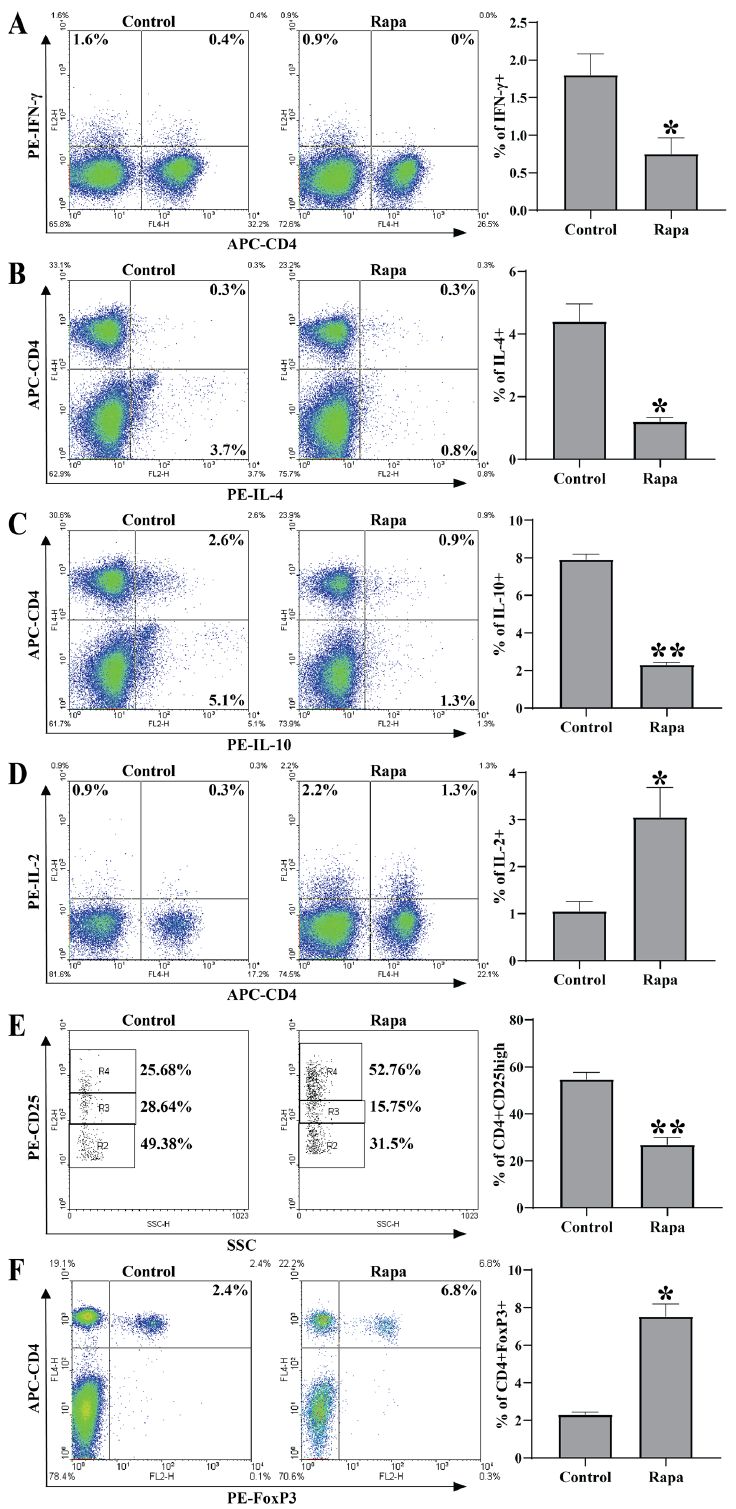
Figure 5. Rapamycin treatment inhibited inflammatory cytokine production while inducing IL-2 production and Tregs population in peripheral blood lymphocytes. ( A – D ) Intracellular cytokine staining of IFN- γ , IL-4, IL-10 and IL-2 in peripheral blood lymphocytes with PMA/ionomycin restimulation. ( E ) Flow analysis of CD25 expression on splenic CD4+ T cells. ( F ) Flow analysis of CD4+FoxP3+ Tregs in Splenic lymphocytes. n = 3 per group, * p < 0.05, ** p <